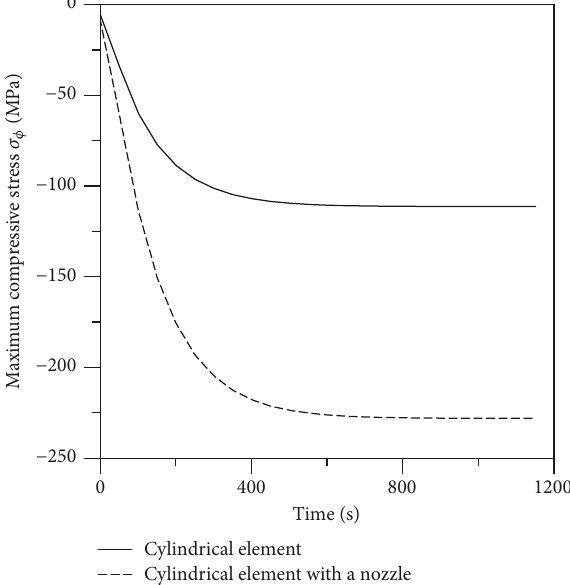
Figure 9: Maximum compressive circumferential thermal stress in a cylindrical component with and without a